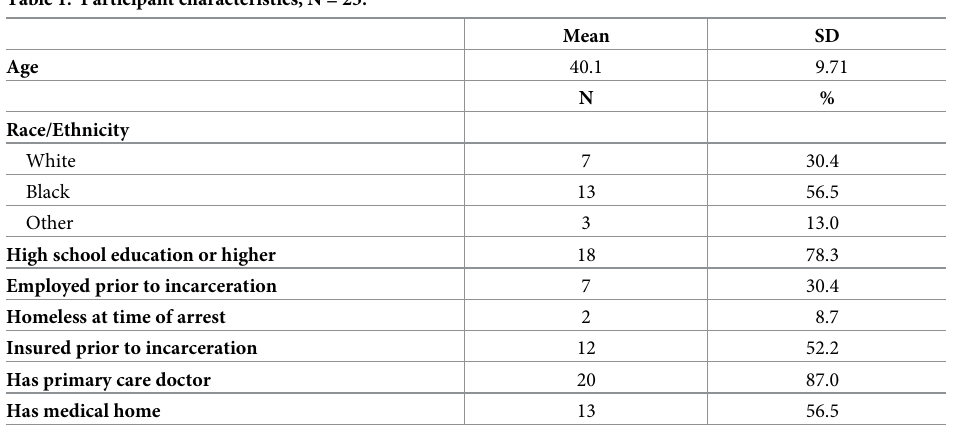
Table 1. Participant characteristics, N = 23.